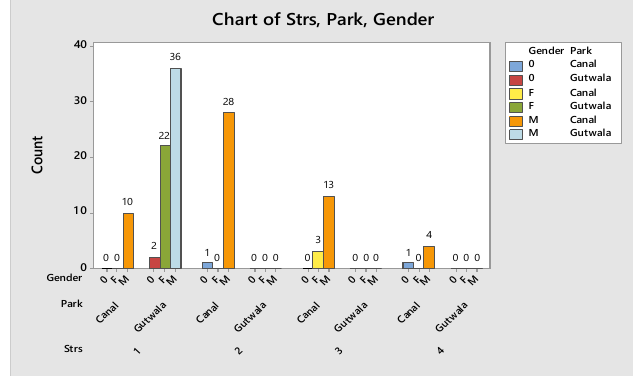
Site-1 Canal Park Site-1 is very high i.e Mean 73.2 dB (A) at locatrion-1 and Mean 63.4 dB(A) at location-2. The observed noise levels at Site-2 Gatwala Park were i.e 54.4 dB(A) and 54.2 dB(A) at location-1 and location-2 respectively. The results then compared with standard fixed by PEPA